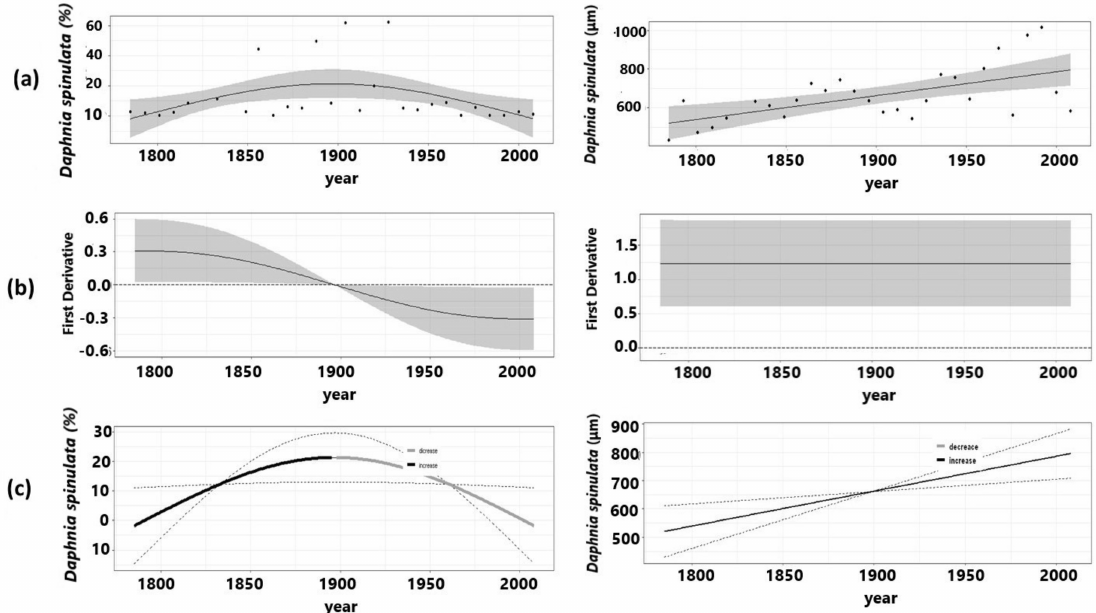
Figure 4. GAM fitted to the time series of Daphnia spinulata ephippia abundance (left pannel) and ephippia size (right pannel) in the sedimentary archive of Lake Blanca Chica. ( a ) Observed values, GAM-based trend fitted and its simultaneous interval; ( b ) estimated first derivative of the GAM fitted trend and the 95% simultaneous interval; ( c ) period of